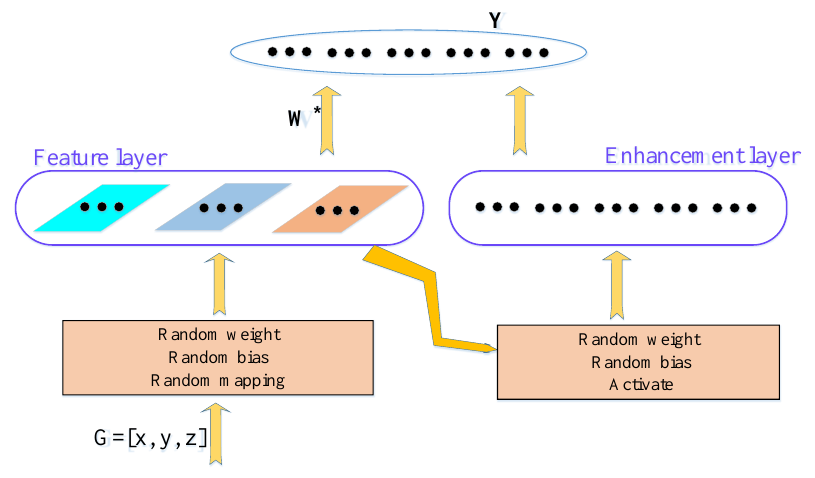
Figure 6. Network structure of